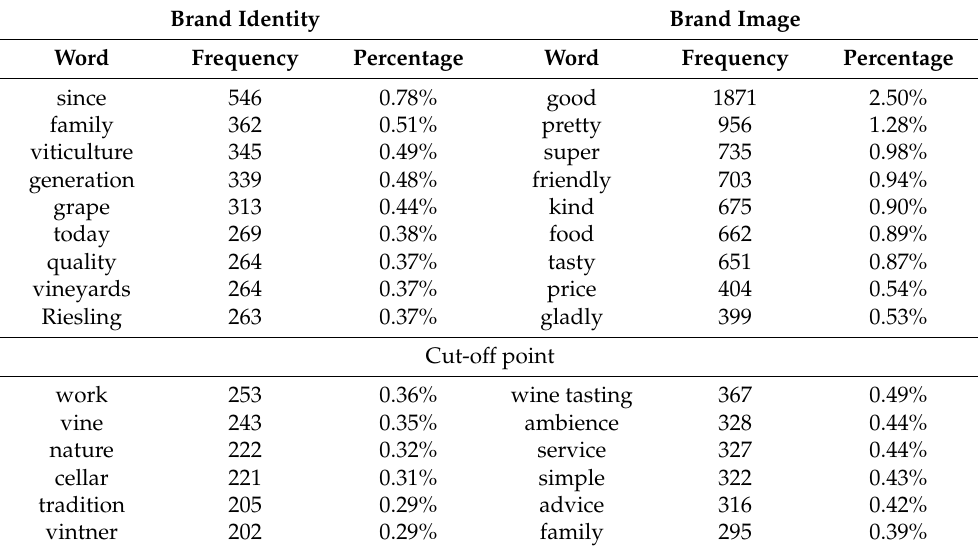
Table 1. Word frequencies for top nine and top fifteen extracted words for both brand identity as well as brand image.